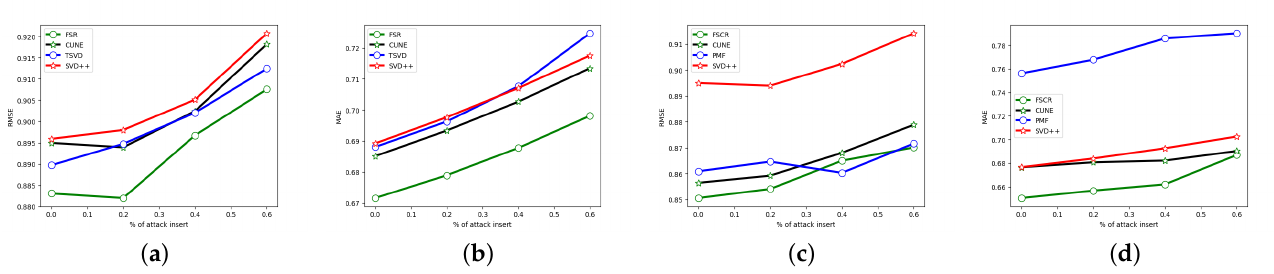
Figure 5. The performance of our model is compared with other baseline models under insertion [0–60%] attack. ( a ) Epinions RMSE, ( b ) Epinions MAE, ( c ) Douban RMSE, ( d ) Douban